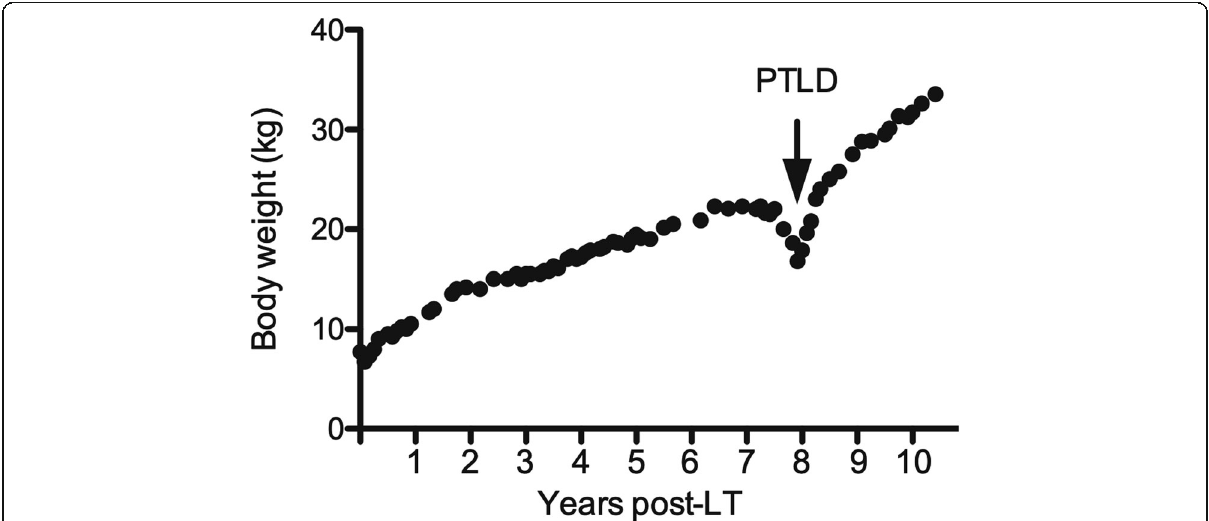
Fig. 1 The body weight post-LT. The data of body weight post-LT were plotted. He had stopped gaining body weight 6 years post-LT and eventually lost body weight. The withdrawal of IS improved the clinical manifestations and recovered body weight